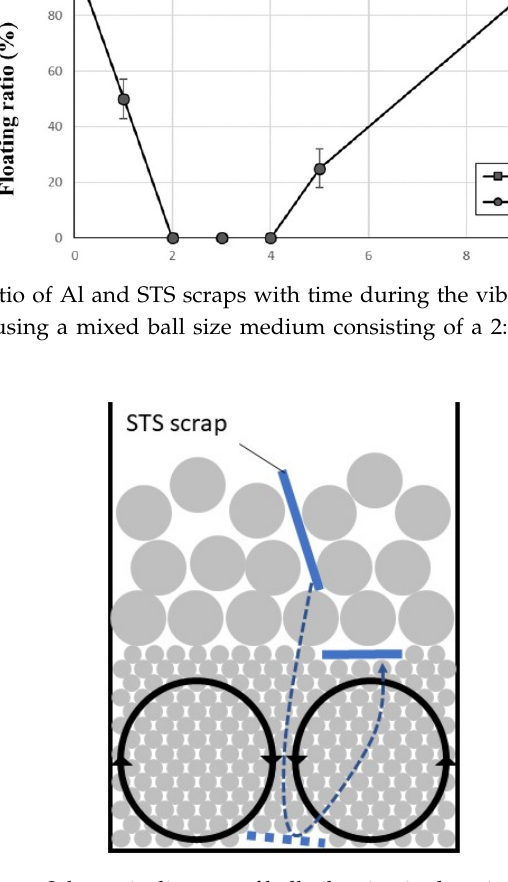
Figure 8. Schematic diagram of ball vibration in the mixed ball bed.